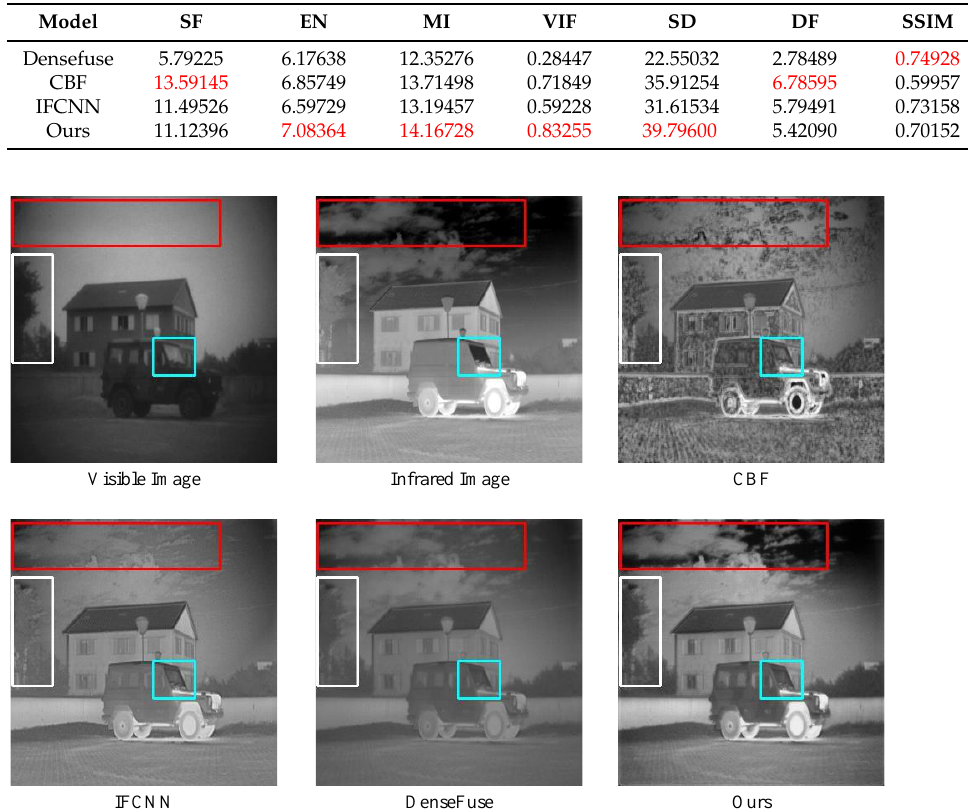
Figure 6. The Result of TNO